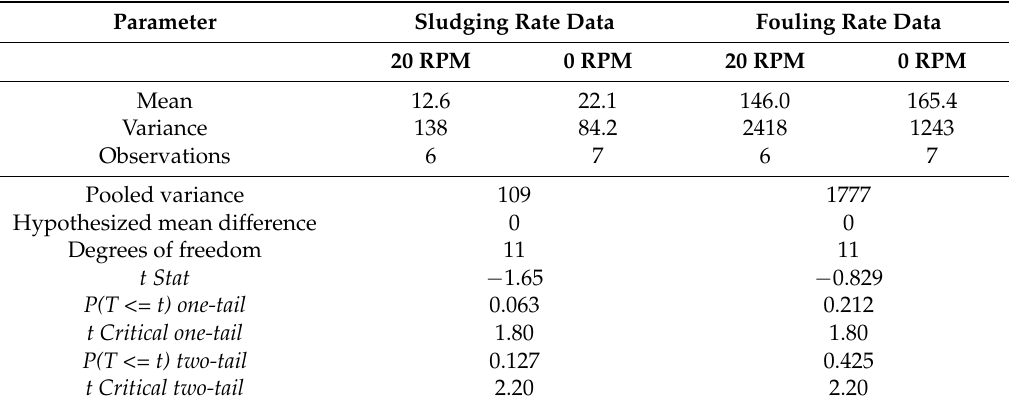
Table 1. Clogging data, Student T Test analysis.